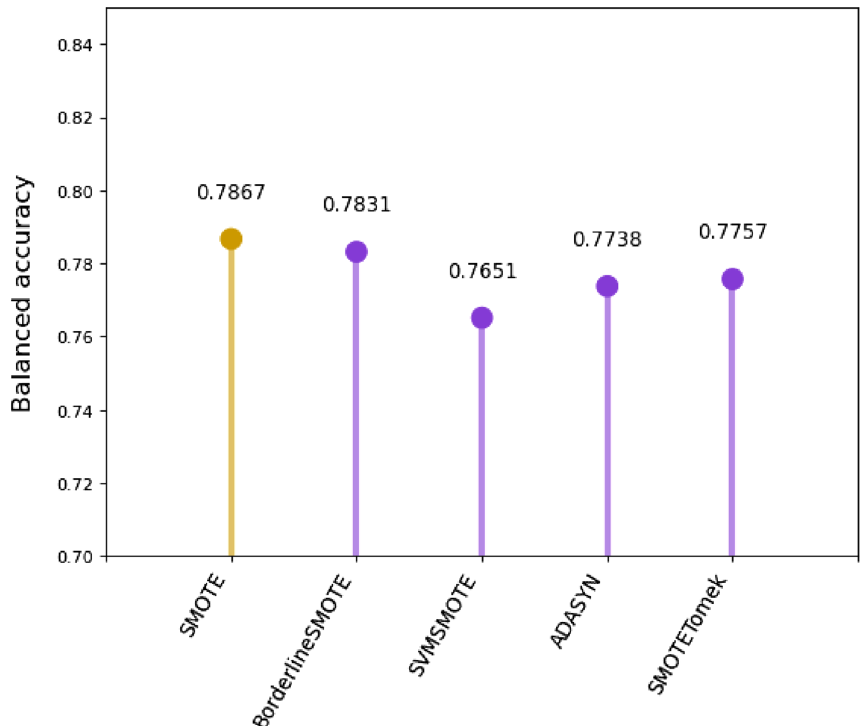
Figure 7. Oversampling algorithms